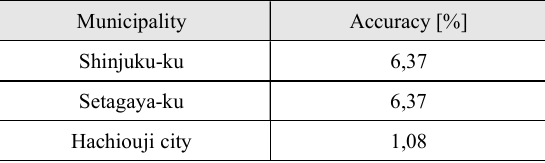
Figure 8 . Example of building extraction from satellite image